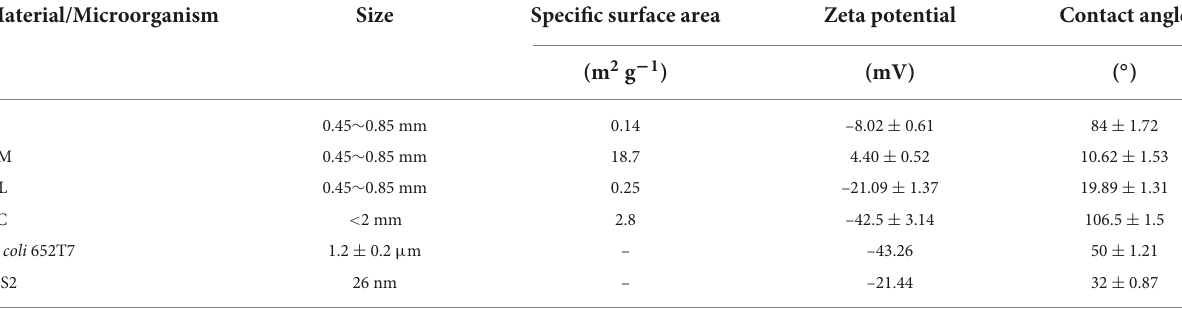
( Figure 1 ). The breakthrough curves of microorganisms from the columns packed with different filtering materials are demonstrated in Figures 2 , 3 . The microorganisms broke TABLE 1 Basic characteristics of iron filings (IF), calcined magnesite (CM), natural ore limestone (OL), corn stalk biochar (BC), and microorganisms. Material/Microorganism